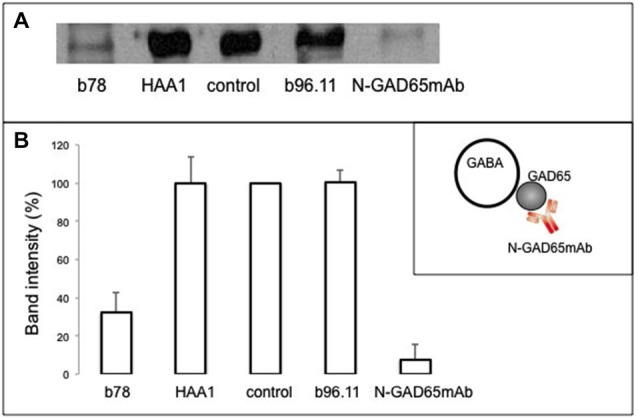
Effect of GAD65Ab on association of GAD65 with GABAergic vesicles. Synaptic vesicles were incubated with monoclonal antibodies b78, HAA1, b96.11, or N-GAD65mAb for 1 h on ice. No antibody was added for the control sample. GABAergic vesicles were isolated as outlined in the inset sketch and the immunoprecipitated proteins were analyzed for the presence of synaptophysin by Western blot. (A) Representative Western blot analysis. (B) Densiometric analysis from three independent experiments. Results are presented as percentage of the corresponding control sample. Error bars represent the standard deviation of the mean. Inset: schematic representation of the experimental set-up.